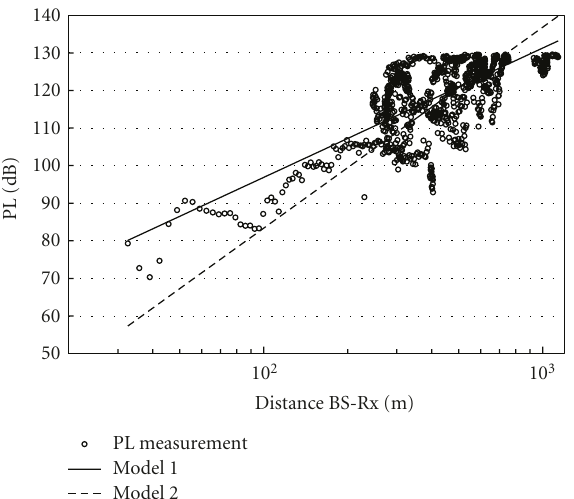
Figure 4: Scatter plot and linear regression fit of path loss (models 1 and 2) at 3520 MHz as function of the distance BS-Rx ( h BS = 15m and h Rx = 2 . 5m).